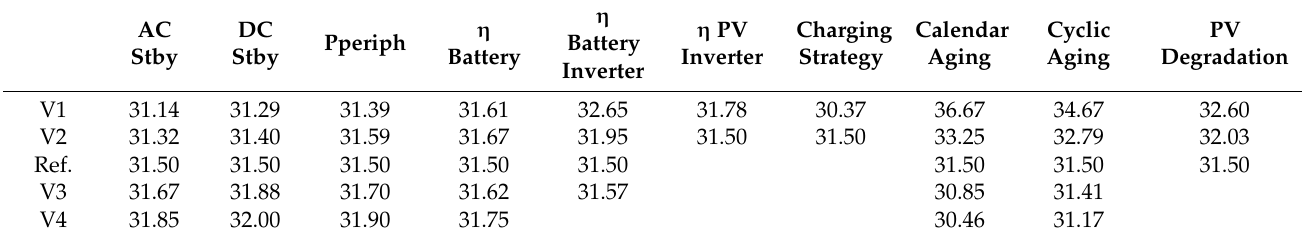
Table A3. Electricity costs in € /kWh depending on the change of different technical parameters. The selected PV system and battery combination is the combination that is the most favorable for the respective boundary